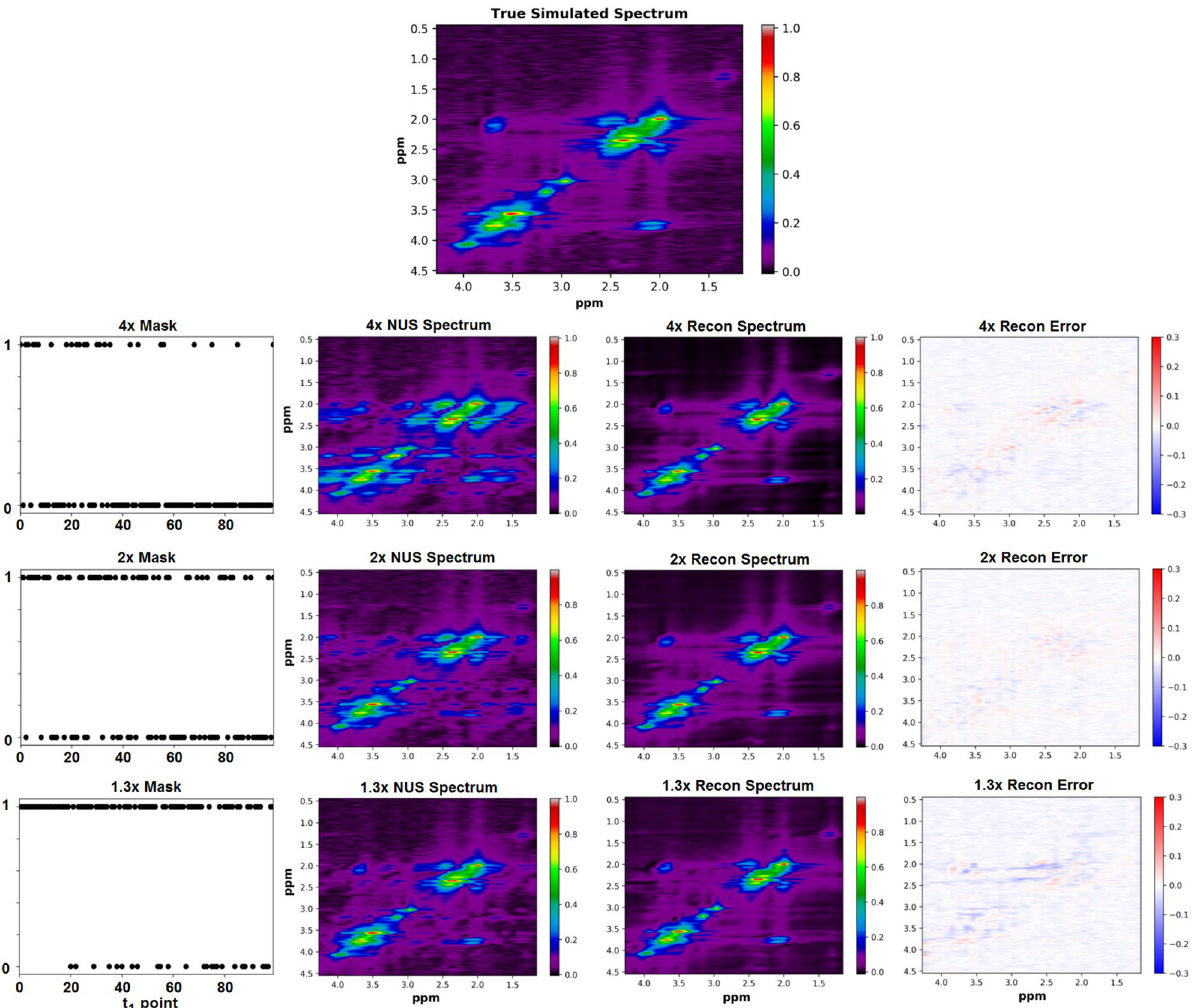
Figure 2. A ground truth simulated L-COSY spectrum is shown (top). Sampling schemes were applied to the simulated spectrum using the sampling masks shown in the 1st column. These masks sampled 25, 50, and 75 t 1 points out of a total 100 t 1 points to yield 4x, 2x, and 1.3x acceleration factors, respectively. The 2nd column shows the under-sampled spectra in the ( F 2 , F 1 ) domain and the 3rd column shows the spectra reconstructed using a D-UNet model. Errors for each reconstruction are displayed as difference maps in the final